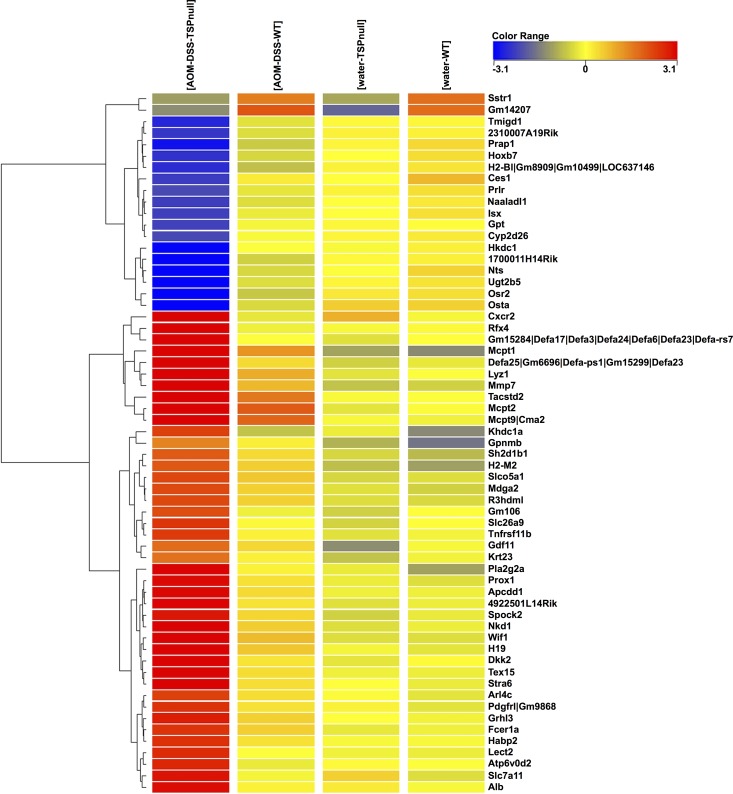
Heatmap of the 61 highly deregulated genes in the AOM-DSS treated mice.A fold-change cutoff of > = 2.0 was used and 342 differentially expressed genes in the treated (tumors) vs. untreated TSP-1-/- (colonic tissue) were detected. In comparing TSP-1-/- to WT tumors, 183 genes were differentially expressed. At a fold-change cutoff of > = 5.0, for the four pairwise comparison, 42 genes showed increased expression and 19 showed lowered transcript levels (p-value < 0.05). Rfx4 (regulatory factor X, 4) and Osr2 (odd-skipped related 2) showed the highest differential expression in the treated groups, TSP-1-/- vs. WT, with Rfx4 expression enhanced by FC = 83.3 and Osr2 expression reduced by FC = 13.3. Transcripts from inhibitors of the Wnt signaling pathway such as WIF1 and Apcdd1 were upregulated in TSP-1-/- tumors. Conversely, transcripts with known neuroendocrine-related functions such as SSTR2 and NST were downregulated in TSP-1-/- tumors.